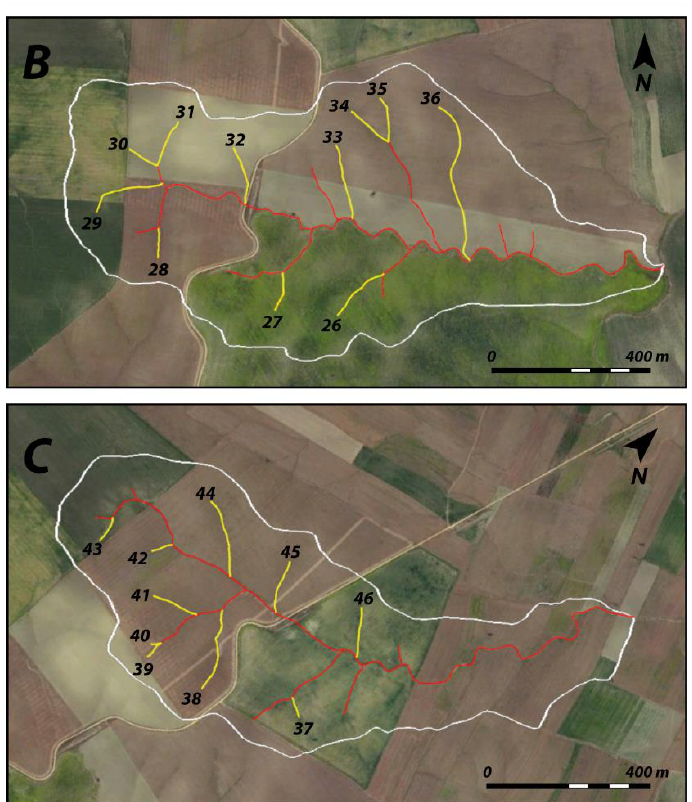
Figure 3. Selected catchments within agricultural areas located 18.5 km northwest of Seville; ( A – C ) catchments A, B, and C, respectively. The measured 46 first-order channels are represented in yellow.